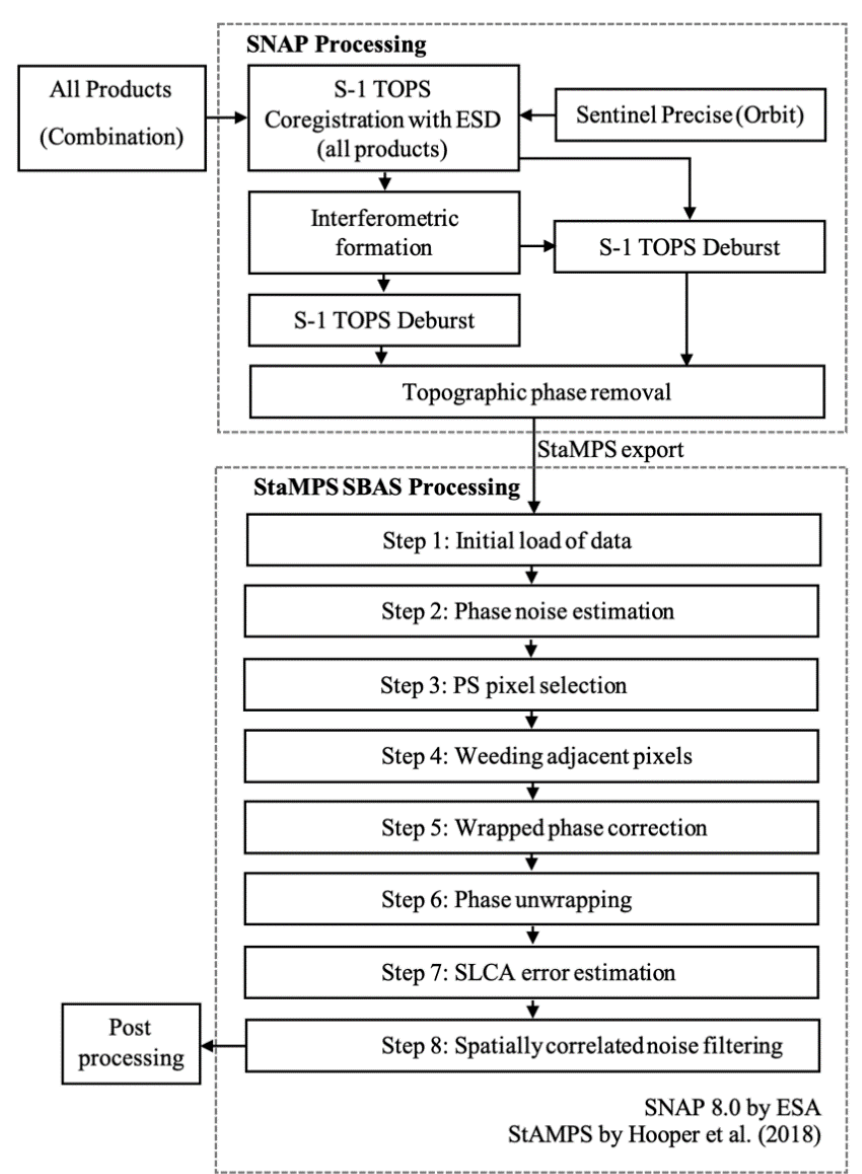
Figure 5. Standard SBAS workflow using SNAP and StaMPS by [42].